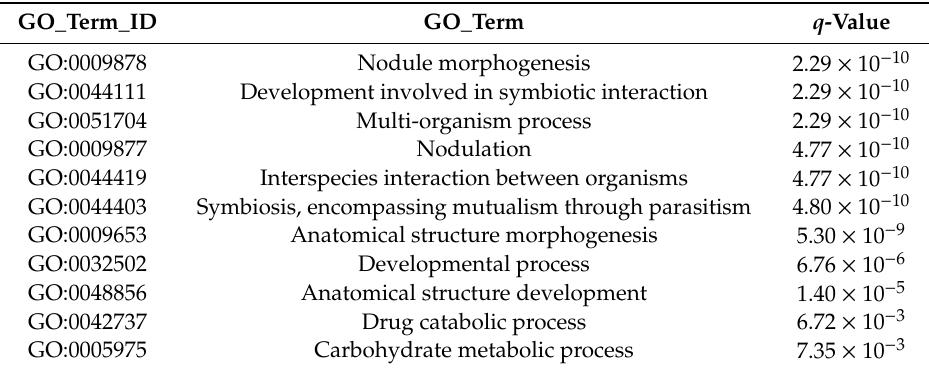
Table 1. Enriched Gene Ontology (GO) terms in di ff erentially expressed genes (DEGs). ID—identifier.